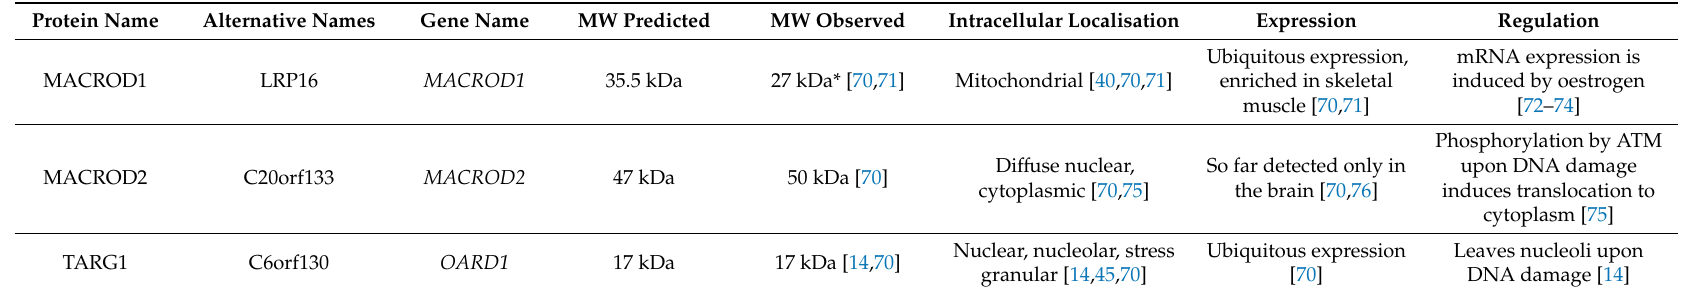
Table 1. Summary of nomenclature, expression, and localisation data of MACROD1, MACROD2, and